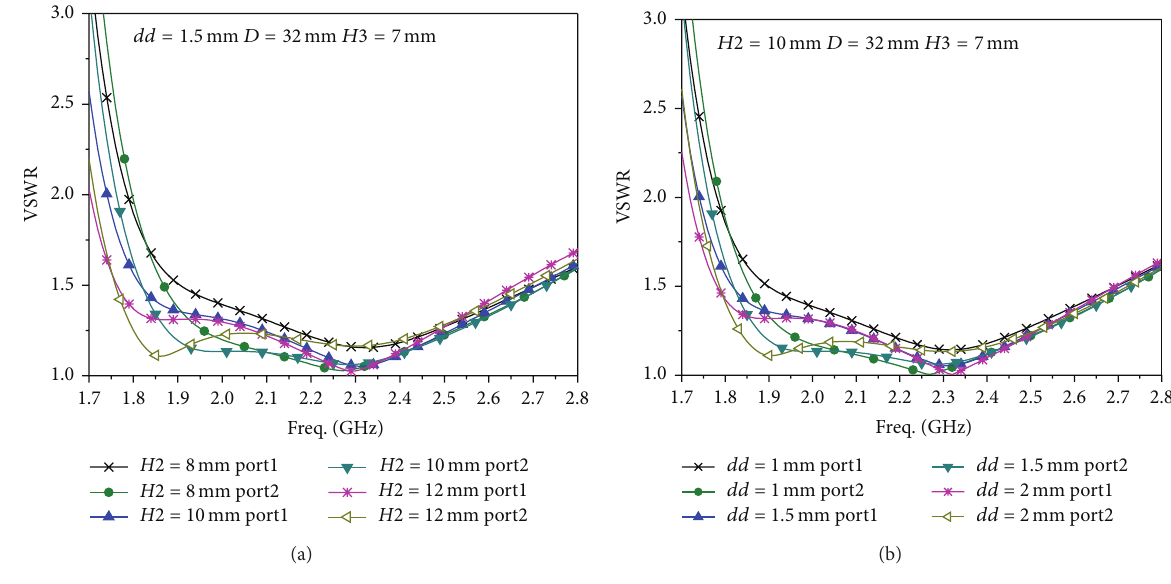
Figure 2: Simulated VSWR for different values of H2 and dd